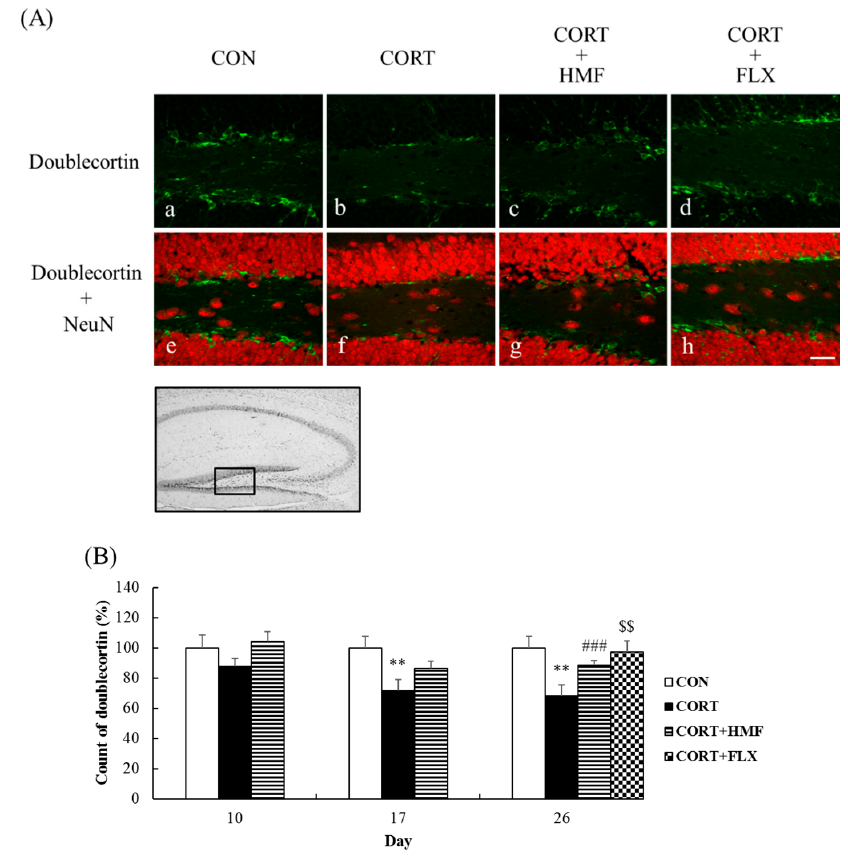
Figure 5. Effects of HMF on the expression of doublecortin immunoreactivity in the corticosterone-induced depressive mouse hippocampal dentate gyrus. ( A ) Sagittal sections on Day 26 after continuous corticosterone injections were stained with specific antibodies, either anti-doublecortin (green; a, b, c, d) or anti-NeuN (red; e, f, g, h). The scale bar shows 50 µm. The location of the captured images in the hippocampus is shown with a square (0.09 mm 2 ). ( B ) A quantitative analysis of doublecortin-positive cell counts was performed manually. Values are means ± SEM (Day 10; n = 4, Day 17; n = 8, Day 26; n = 8–10). Symbols show significant differences between the following conditions: CON vs. CORT (** p < 0.01), CORT vs. CORT + HMF ( ### p < 0.001), and CORT vs. CORT + FLX ( $$ p < 0.01).